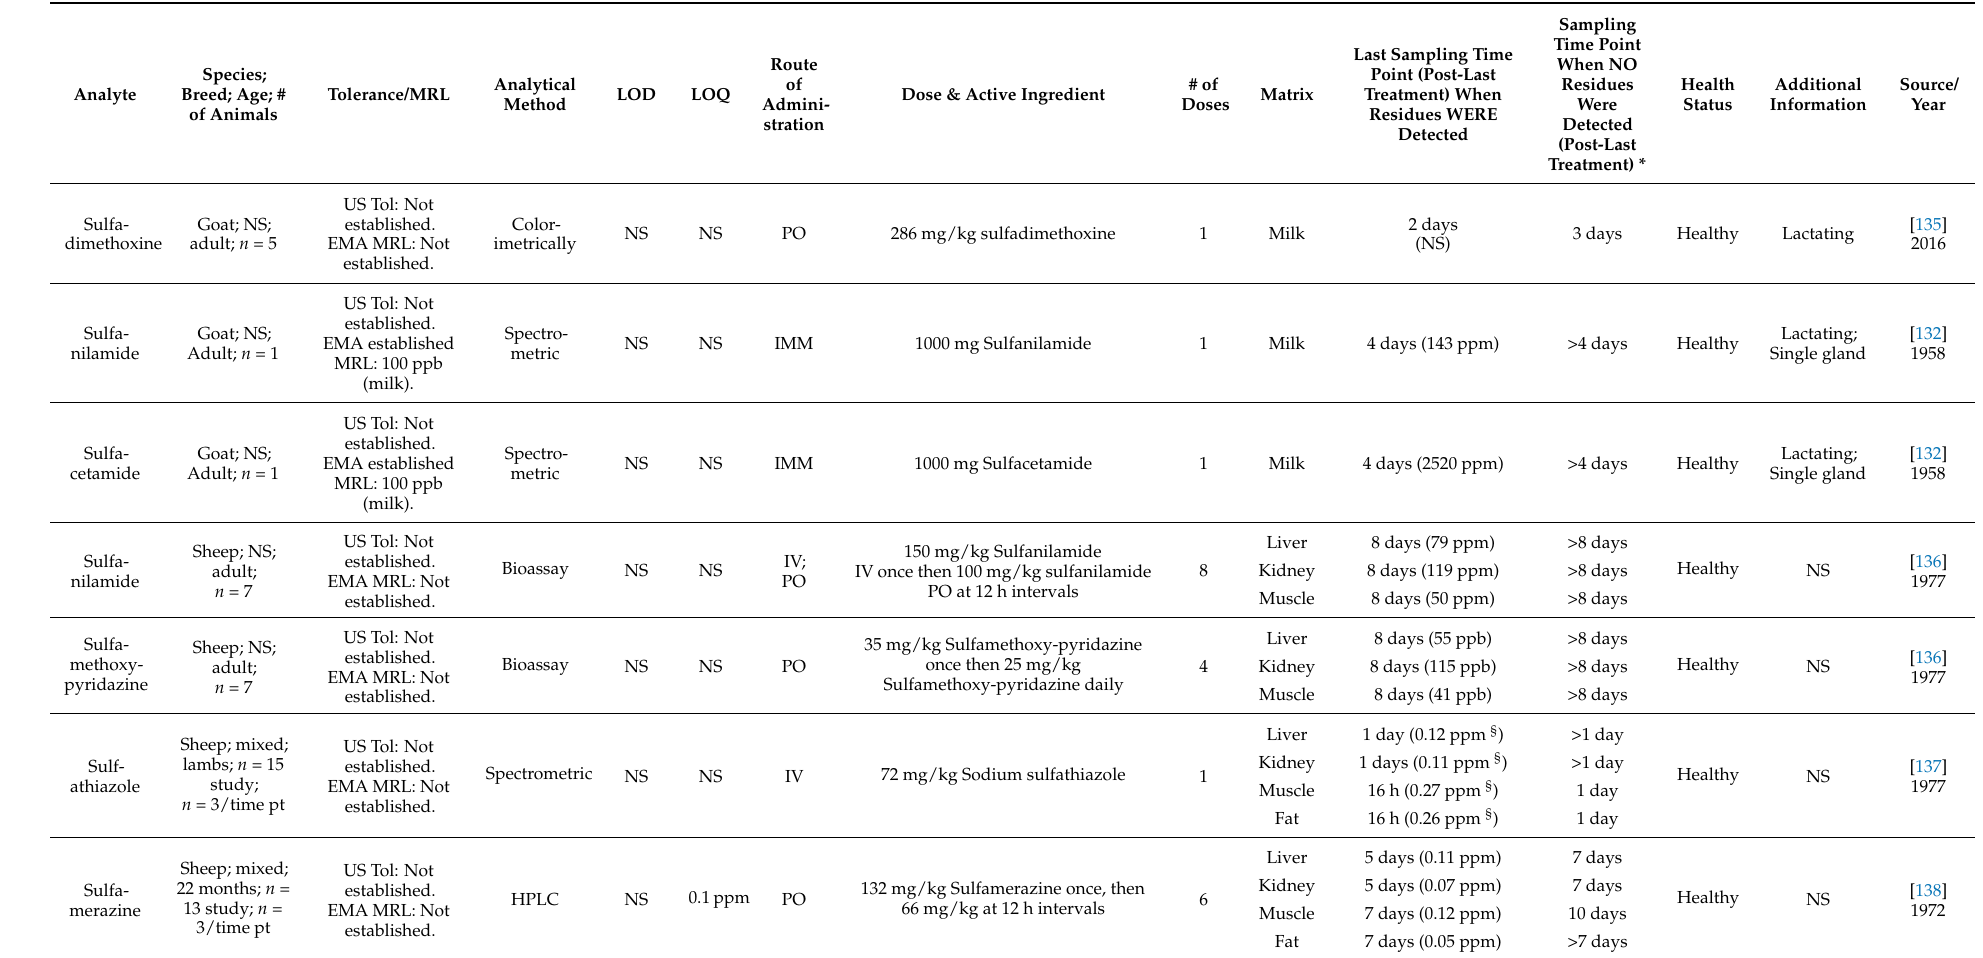
Table 7. Sulfonamide residues in milk or edible tissue samples from sheep or goats following treatment.